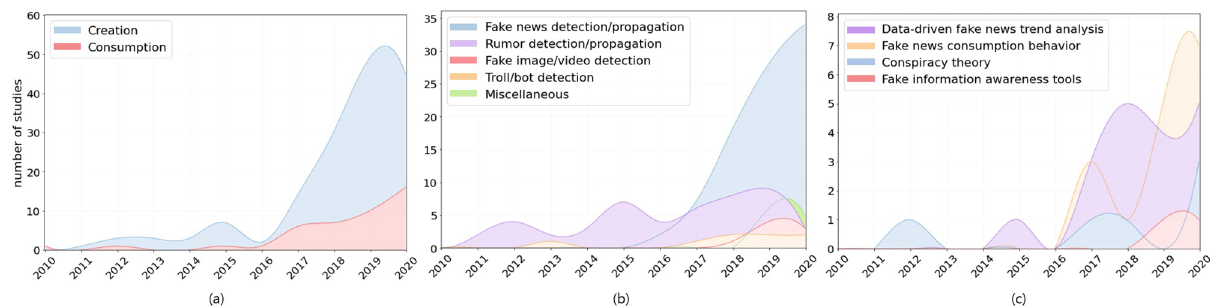
Fig 4. Fake news research trends of the past decade (2010–2020). We collected 2,277 fake news related-papers and randomly chose and categorized 200 papers. Each marker indicates the number of fake news studies per type published in a given year. Fig 4(a) shows a research trend of news creation and consumption (main category). Fig 4(b) and 4(c) show a trend of the sub-categories of news creation and consumption. In Fig 4(b), “Miscellaneous” includes studies on stance/propaganda detection and a survey paper. In Fig 4(c), “Data-driven fake news trend analysis” mainly covers the studies reporting the influence of fake news that spread around specific political/social events (e.g., fake news in Presidential Election 2016, Rumor in Weibo after 2015 Tianjin explosions). “Conspiracy theory” refers to an unverified rumor that was passed on to the